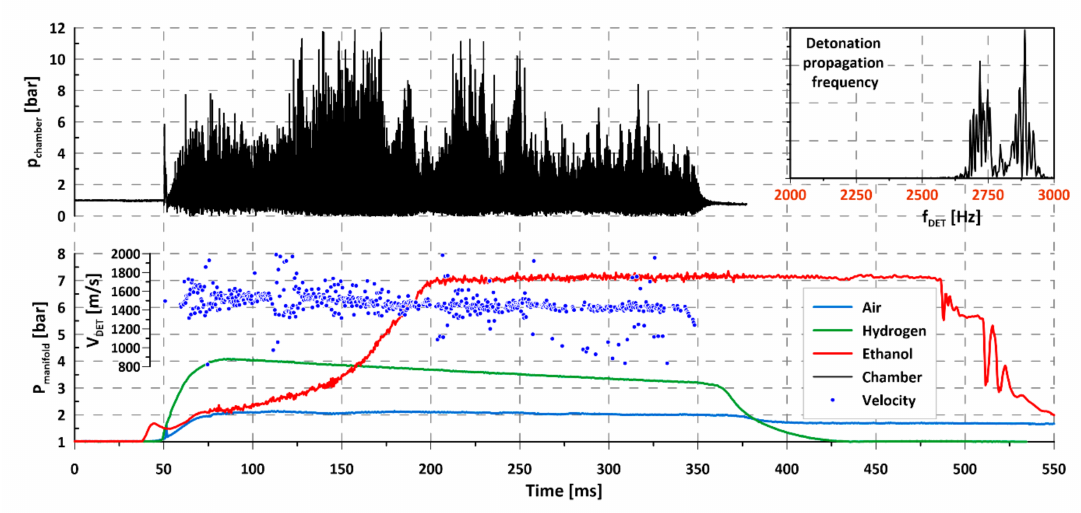
Figure 9. Propagation of rotating detonation for liquid ethanol (C 2 H 5 OH)–air mixture with hydrogen